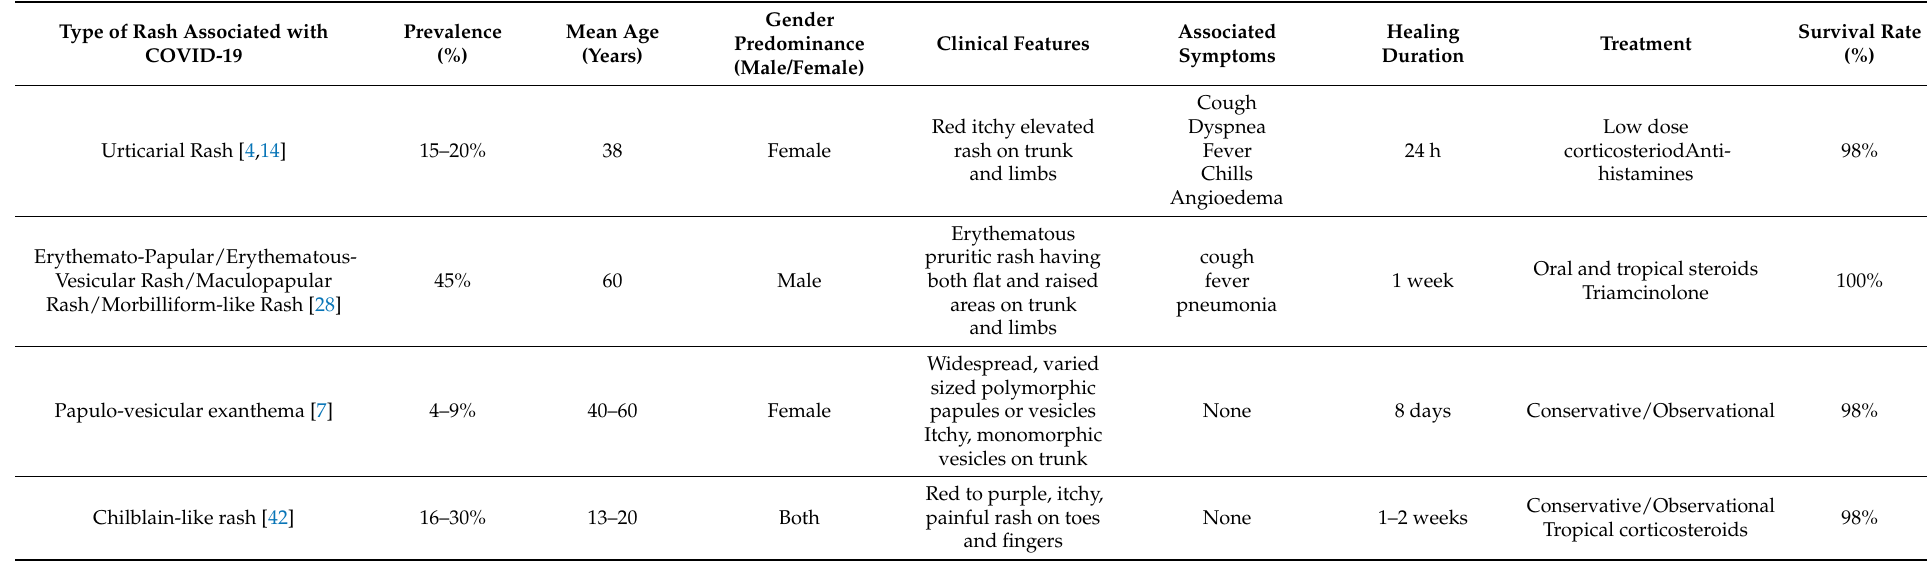
Table 1. Summary of cutaneous manifestations of